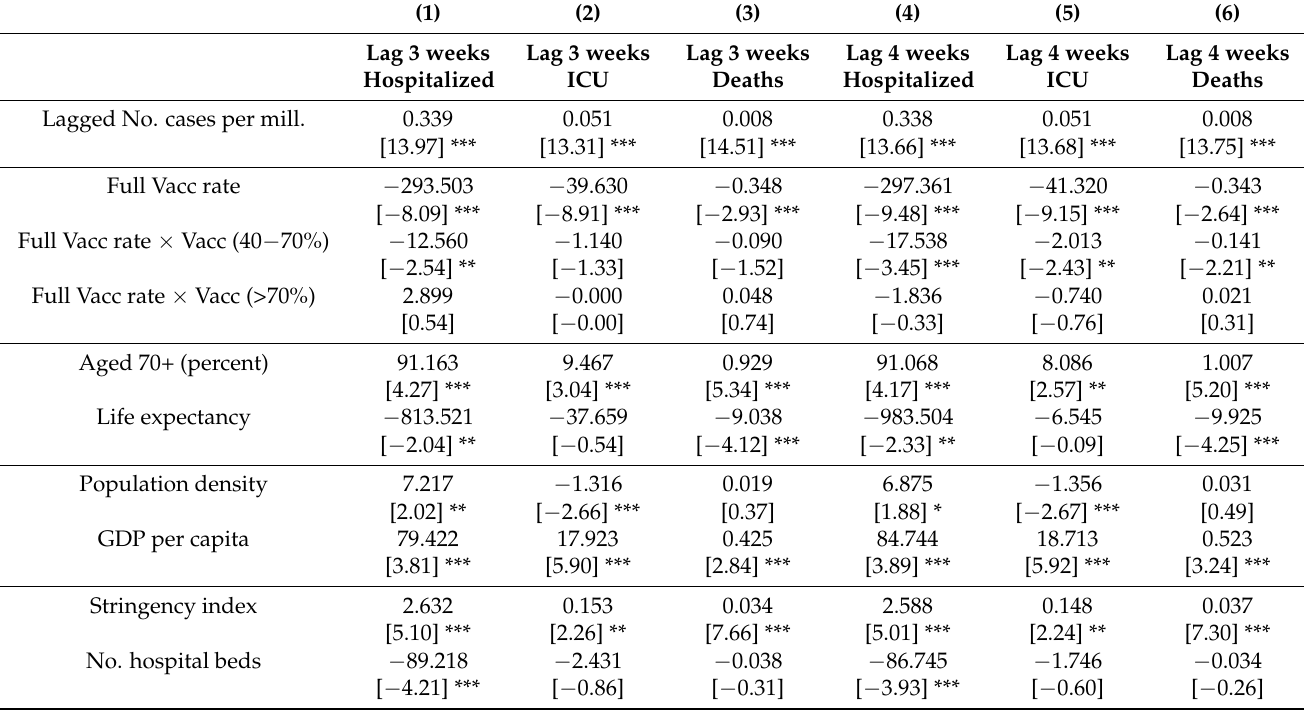
Table A9. Impact of vaccination rate on number of hospitalizations, ICU admissions and deaths in 2021 compared to